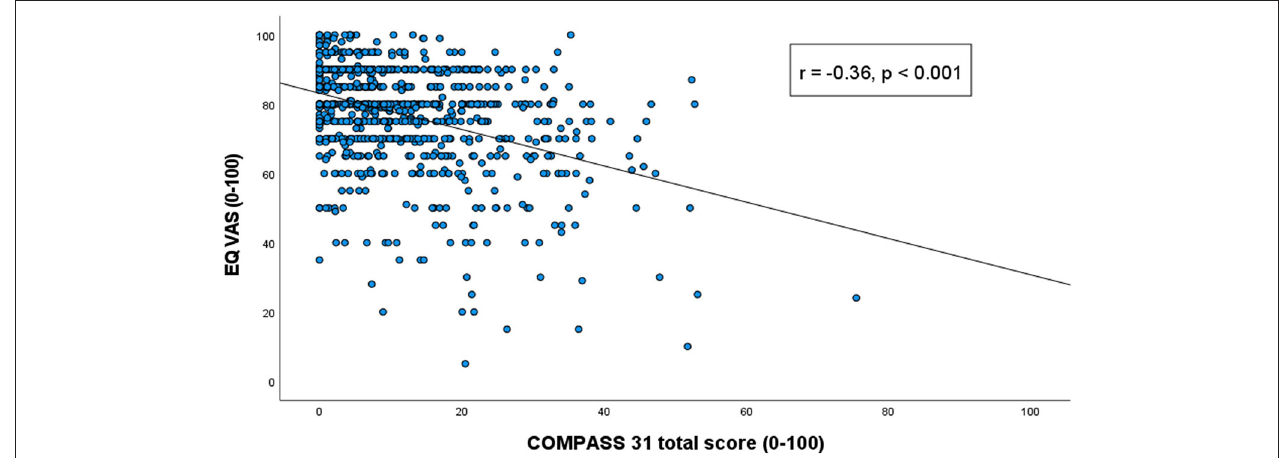
FIGURE 1 | Correlation between COMPASS 31 total score and the Visual Analog Scale scores of the EuroQol five-level version of EQ-5D. Correlation values presented with Spearman’s rho correlation coefficient and p -value for each